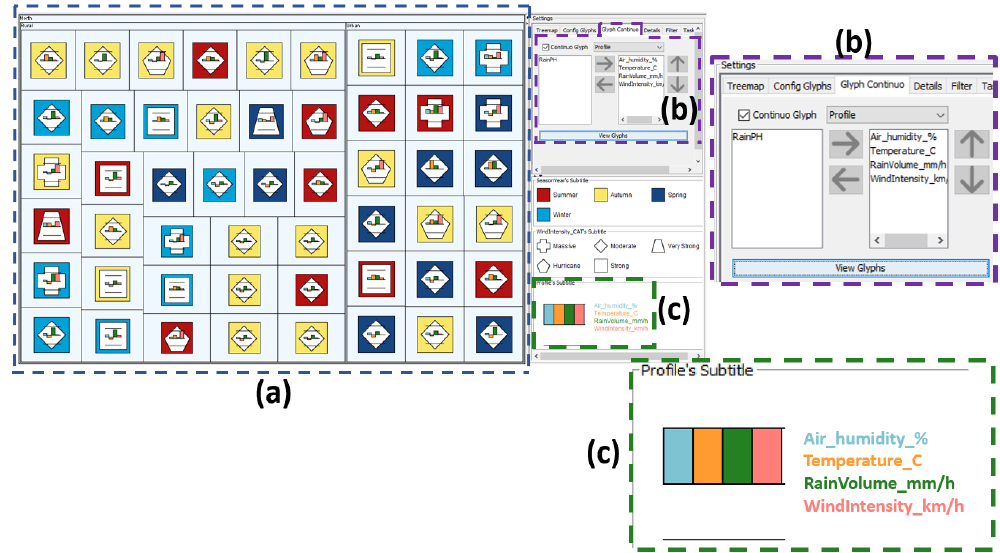
Figure 7. ( a )—An overview of the treemap with quantitative glyphs and hierarchy. ( b )—Profile glyph dimensions configuration. ( c )—Profile glyph